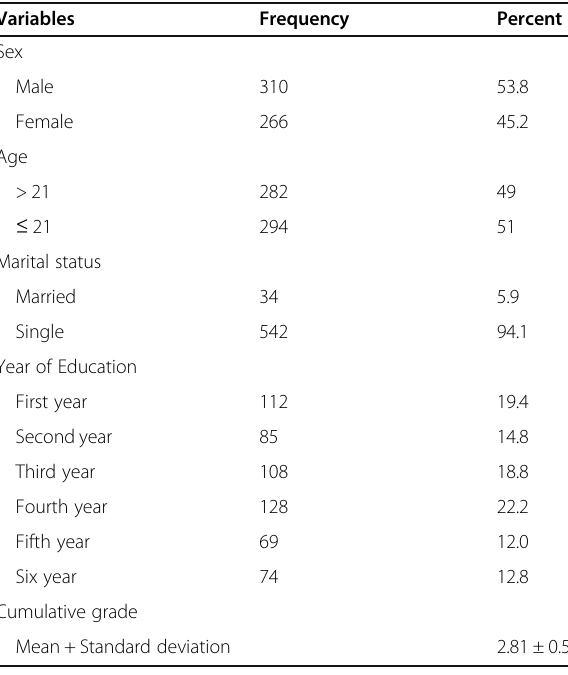
Table 1 Socio demographic characteristics among undergraduate medical students at Tikur Anbessa Specialized